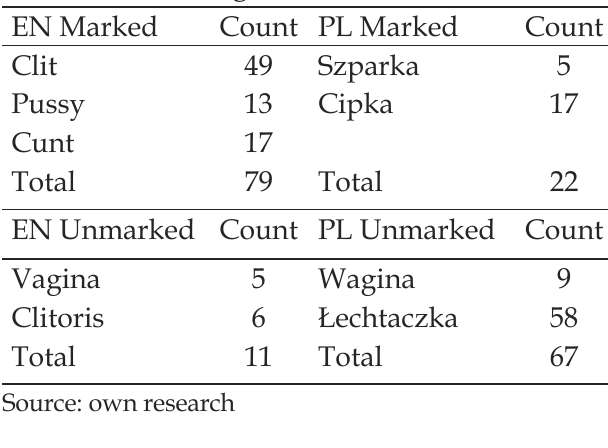
The distribution of marked and unmarked vocabulary items related to female genitals in source and target texts